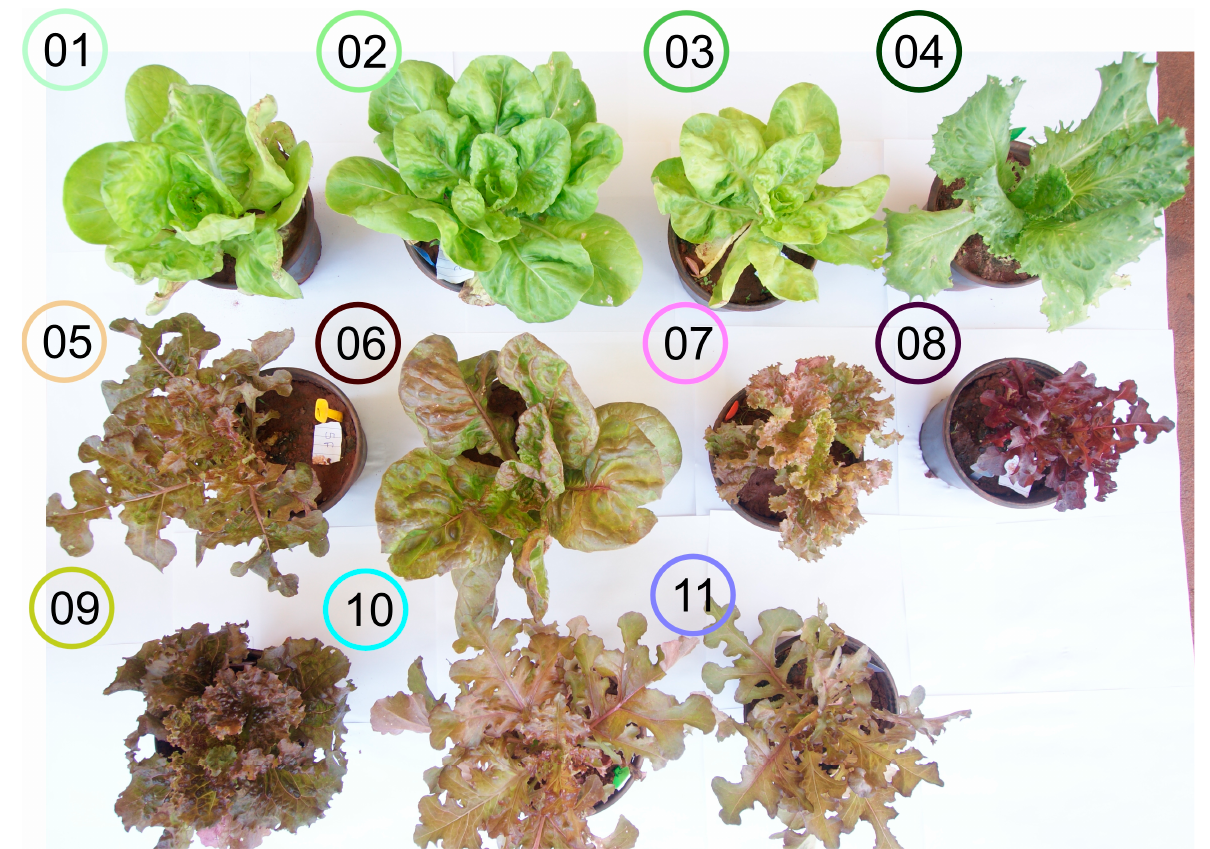
Figure 1. Lactuca sativa L. plants with variation of pigments. The circle displays eleven different varieties of the left to right and top to bottom ( V01 – V11 ) variations as described in the Section 4 [3,8].